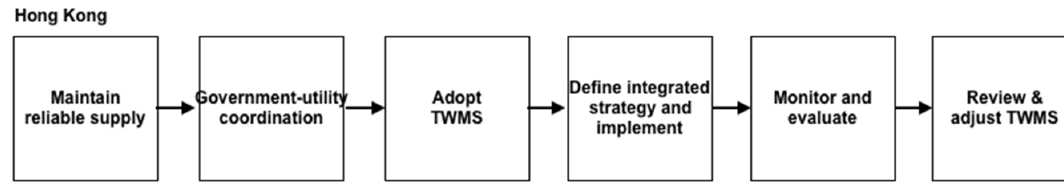
Figure 2. Process tracing adoption of IUWM in Hong Kong.